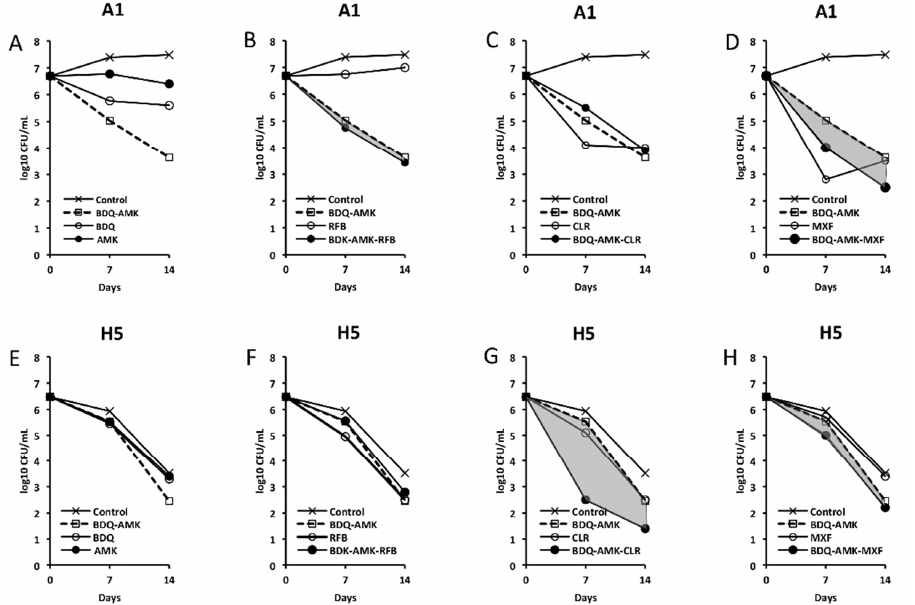
Figure 3. Activity against A1 and H5 cells of 3-drug combinations containing bedaquiline-amikacin (BDQ-AMK). ( A , E ) BDQ-AMK and its components BDQ and AMK; ( B , F ) BDQ-AMK ± rifabutin (RFB); ( C , G ) BDQ-AMK ± clarithromycin (CLR); ( D , H ) BDQ-AMK ± moxifloxacin (MXF). Increases in the activities of (BDQ-AMK + third drug) versus BDQ-AMK are highlighted in grey.